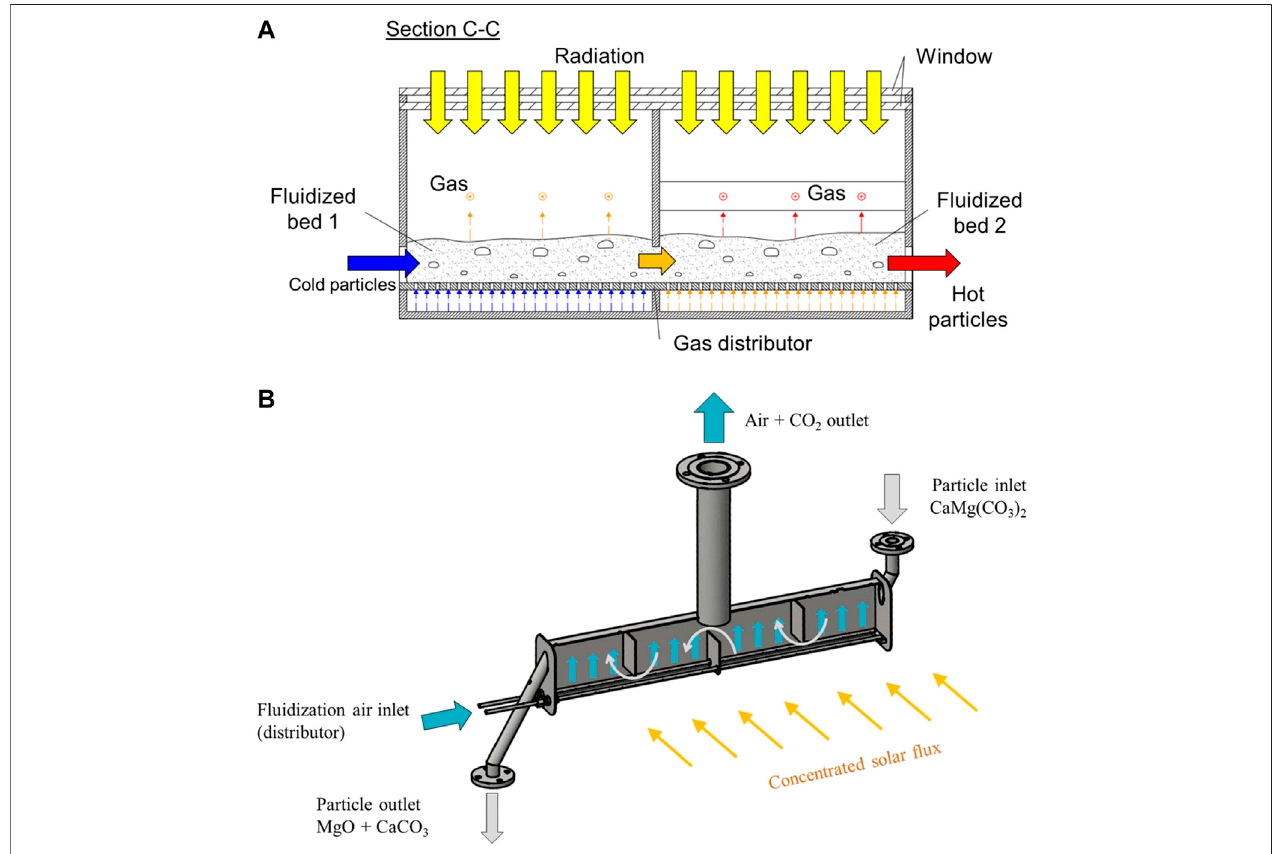
FIGURE 7 | Multistage horizontal fl uidized beds: (A) Schematic of the linear solar particle receiver (reprinted from Gómez-Hernández et al. (2018) with the permission of AIP Publishing); (B) The shallow cross- fl ow fl uidized bed reactor (reprinted from Esence et al. (2020a), distributed under a Creative Commons Attribution (CC BY)